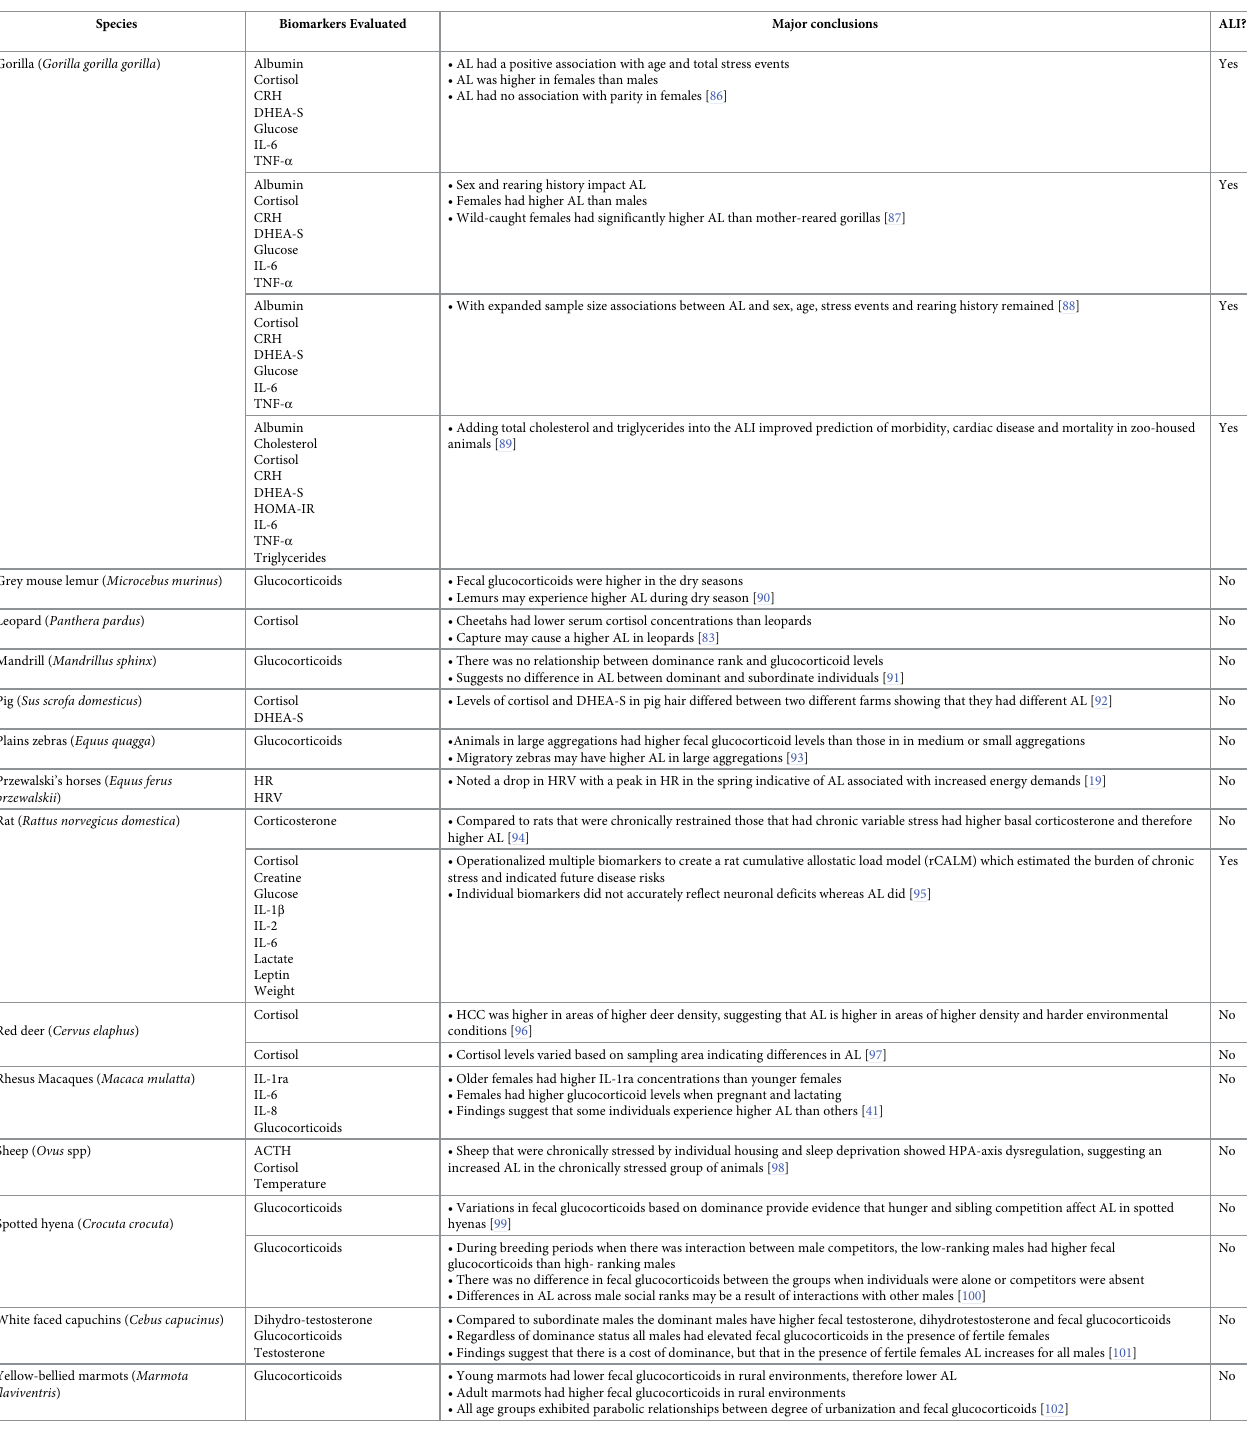
Atotalof61primaryresearchpublicationsthatmadedirectassessmentsaboutallostasisand/orallostaticloadinnon-humananimals,includinganimalclass,species,biomarkersevaluated,majorconclusionsandwhetheranallostaticloadindex (ALI)wasconstructed. Abbreviations:ACTH,adrenocorticotropichormone;AL,allostaticload;ALI,allostaticloadindex; α -MSH, α -melanocyte–stimulatinghormone;BKA,bacterialkillingactivity;Ca2+,calcium;Cl-,chloride;CRH,corticotropin-releasing hormone,DHEA,dehydroepiandrosterone;DHEA-S,dehydroepiandrosterone-sulfate;Hb,hemoglobin;HCC,haircortisolconcentration;Hct,hematocrit;HOMA-IR,homeostaticmodelassessmentofinsulinresistance;HR,heartrate;HRV, heartratevariability;IL-1ra,interleukin-1receptorantagonist;IL-2,interleukin-2;IL-6,interleukin-6;IL-8,interleukin-8;K+,potassium;LVP,lys8-vasopressin;Mg,magnesium;Na+,sodium;PCO2,partialpressureofcarbondioxide;PCV, packedcellvolume;RBC,redbloodcells;TNF- α ,tumornecrosisfactoralpha